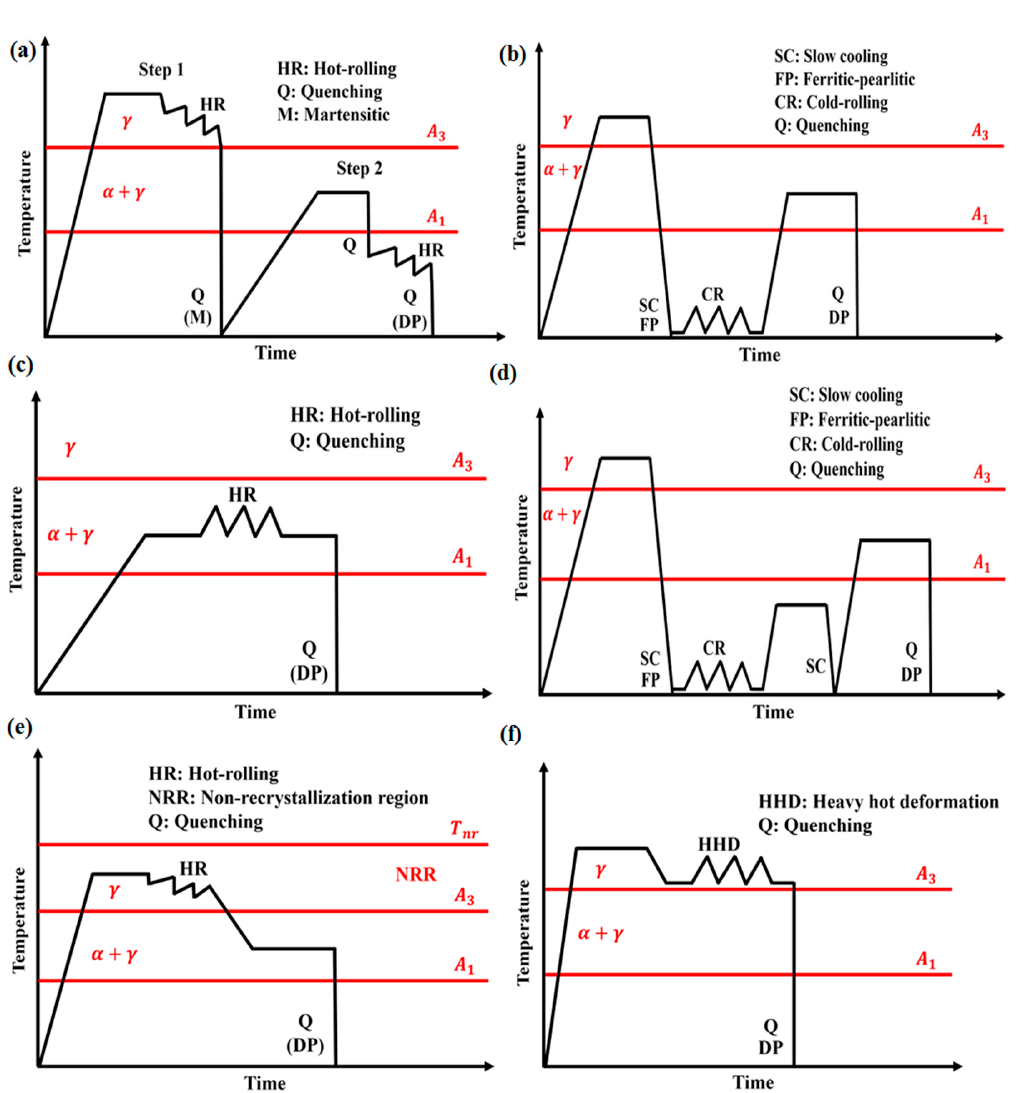
Figure 6. Various heat-treatment regimes: ( a ) processing route 8, ( b ) processing route 9, ( c ) processing route 10, ( d ) processing route 11, ( e ) processing route 12, and ( f ) processing route 13 for FGS